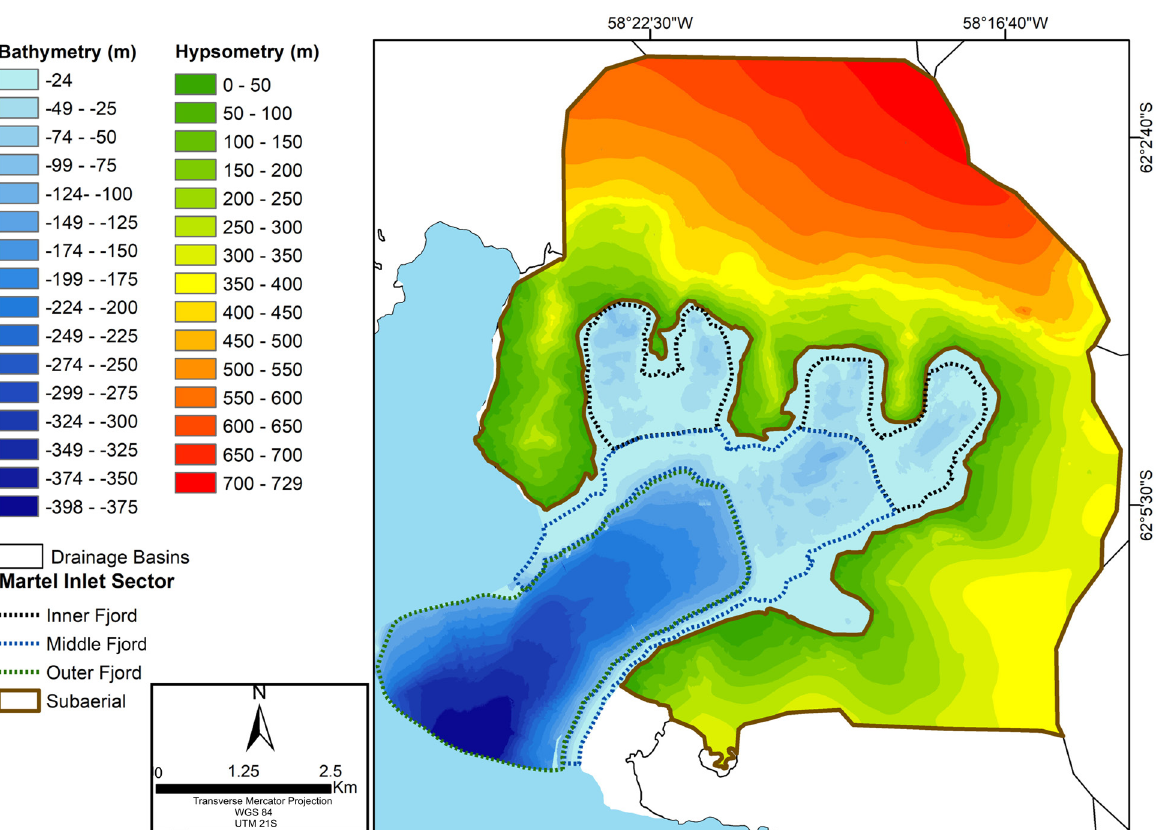
Figure 4. Bathymetric/hypsometric map of MI submarine and subaerial